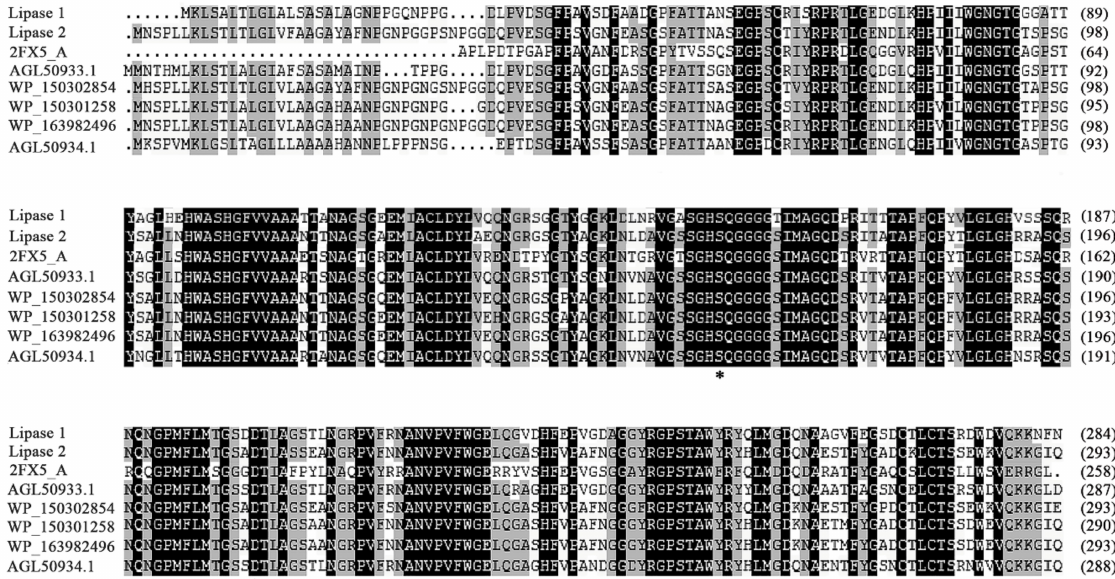
Figure 6. Alignment of Lipase 1, Lipase 2, and other reported homologs, in which 2FX5_A indicates a lipase from Pseudomonas mendocina , AGL50933.1 indicates a cold-active lipase precursor from an uncultured bacterium, WP_150302854 indicates an alpha/beta hydrolase from Pseudomonas sp. 16W4-4-3 T , WP_150301258 indicates an alpha/beta hydrolase from Pseudomonas profundi , WP_163982496 indicates an alpha/beta hydrolase from Pseudomonas sp. OIL-1 T , and AGL50934.1 indicates a cold-active lipase precursor from an uncultured bacterium. Asterisks indicate the mutation